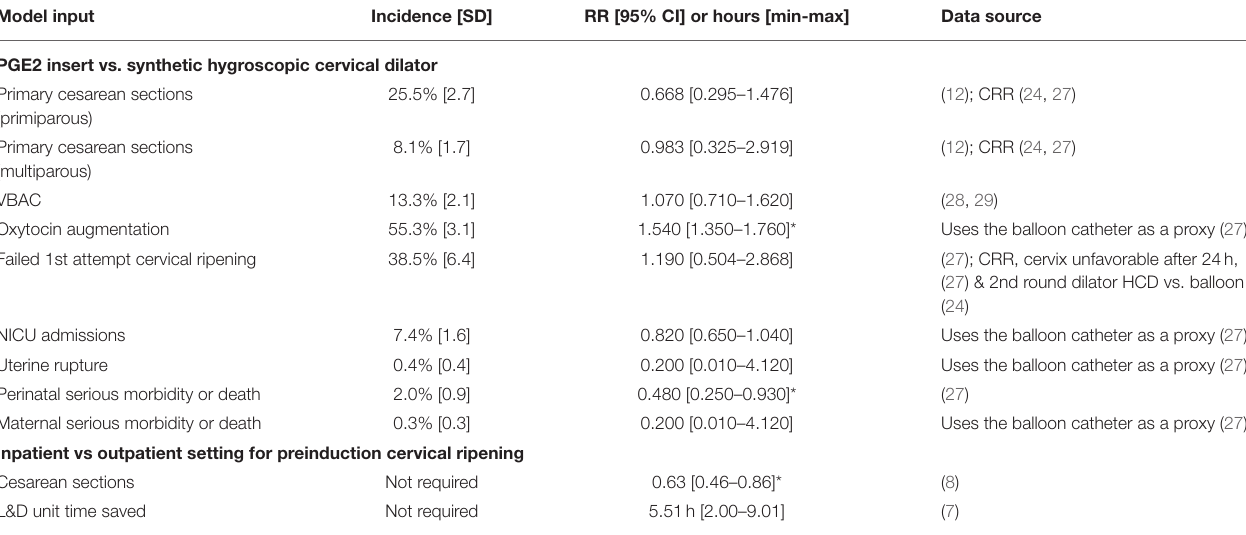
TABLE 2 | Model inputs for clinical